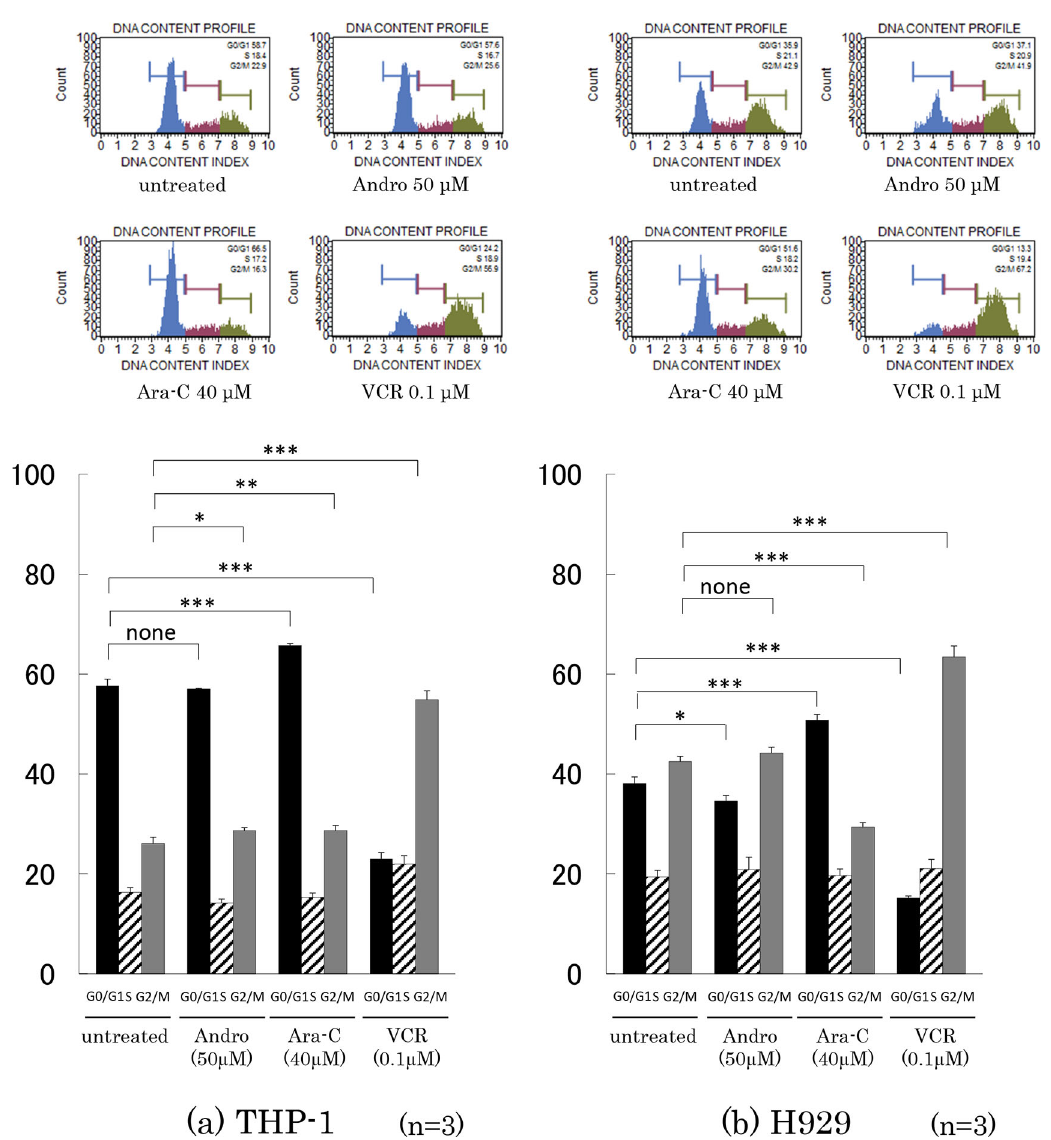
Figure 3. Cell cycle phase distribution of the cells treated with Andro, Ara-C, or VCR. Cell cycle phases of individual cells were measured after treatment for 24 h with Andro (50 μ M), Ara-C (40 μ M), or VCR (0.1 μ M) using the Muse Cell Analyzer. In contrast to Ara-C and VCR, treatment with Andro hardly affected the percentages of THP-1 or H929 cells found in the G0/G1, S, and G2/M phases. Percentages are expressed as mean of three independent experiments.Forstatisticalanalysisthepercentagesofcellsinidenticalphaseswerecompared(*P<0.05,**P<0.01, ***P < 0.001). The top of the figure shows cell cycle histograms of representative